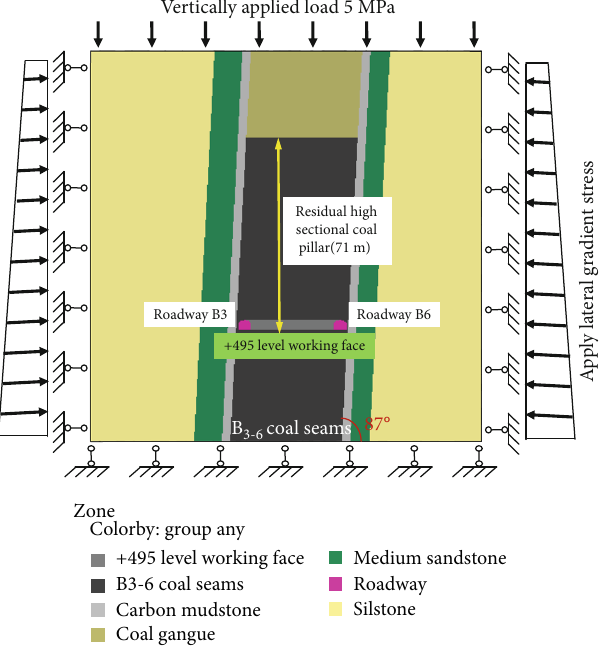
Figure 4: FALC 3D numerical